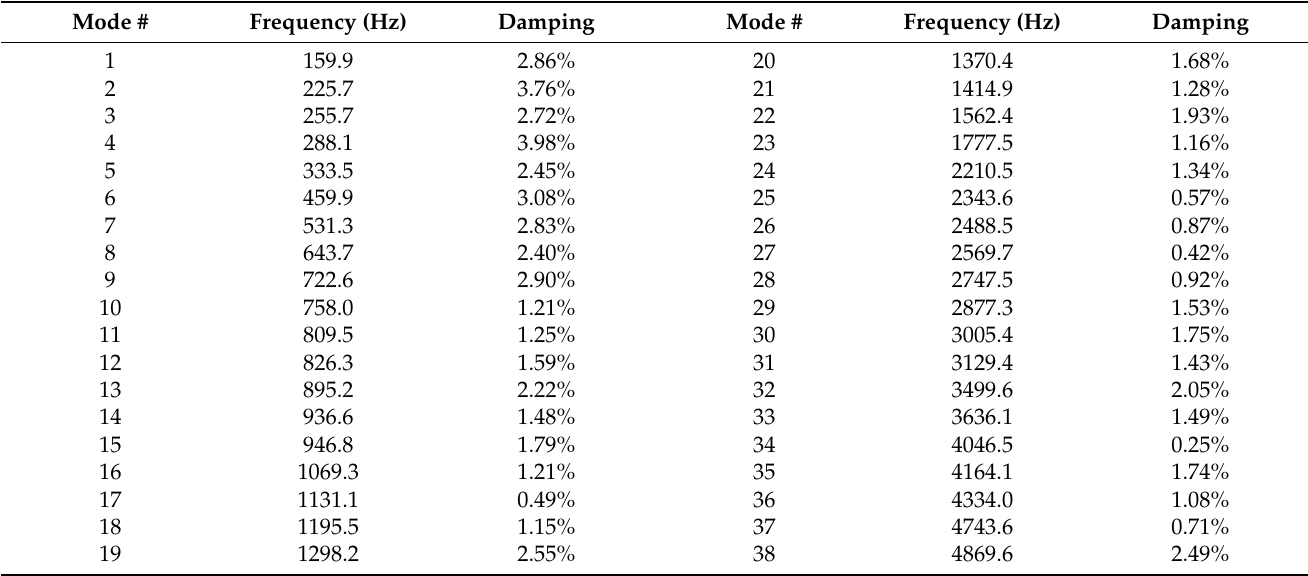
Table 2. The experimental modal frequencies and damping